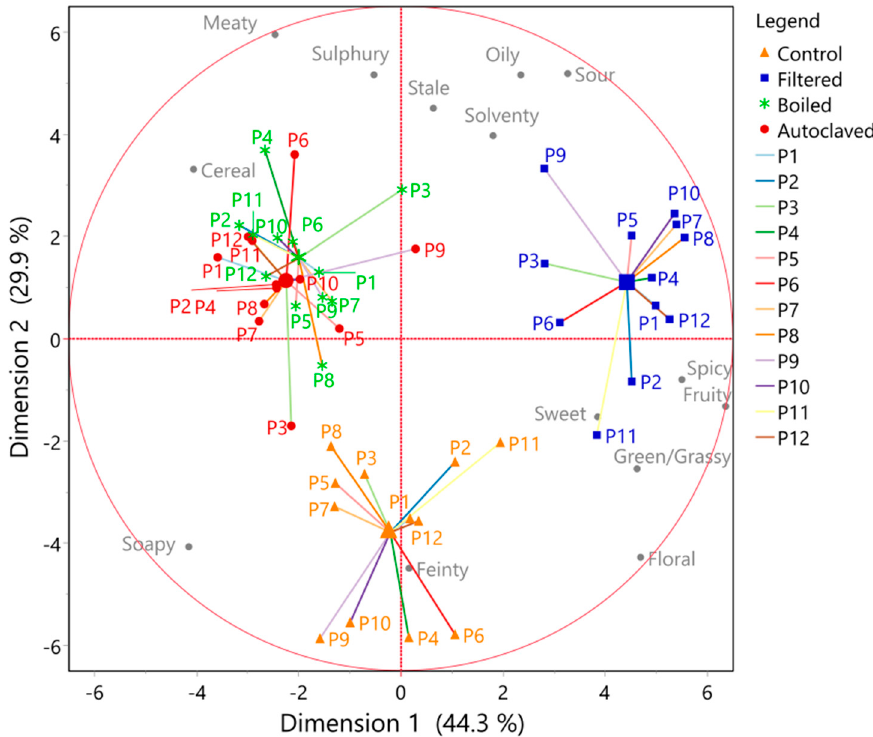
Figure 5. MFA plot of the QDA data, resulting from 12 panellists, for spirits of four pretreatment conditions for wort MFA analysis, for each panellist first.